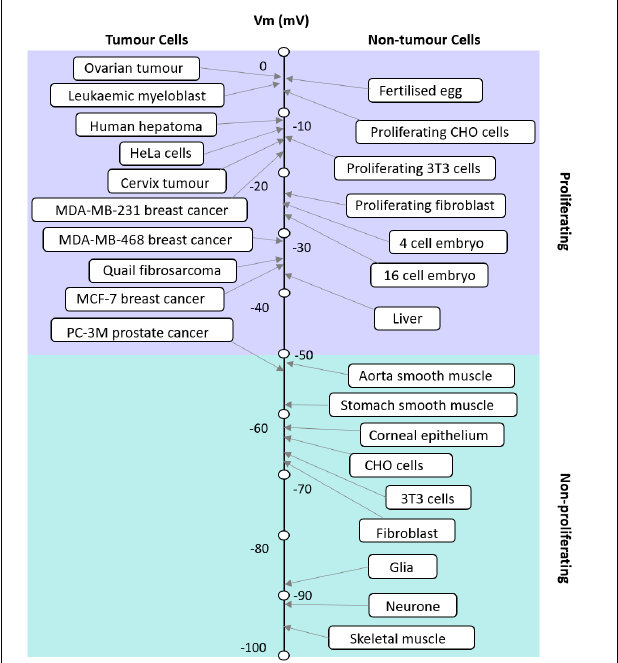
FIGURE 1 | Apparent correlation between the RMP and proliferative potential of cells. The RMP of tumor and non-tumor cells and their proliferation potential are shown. Modified with permission from the copyright holders Yang and Brackenbury